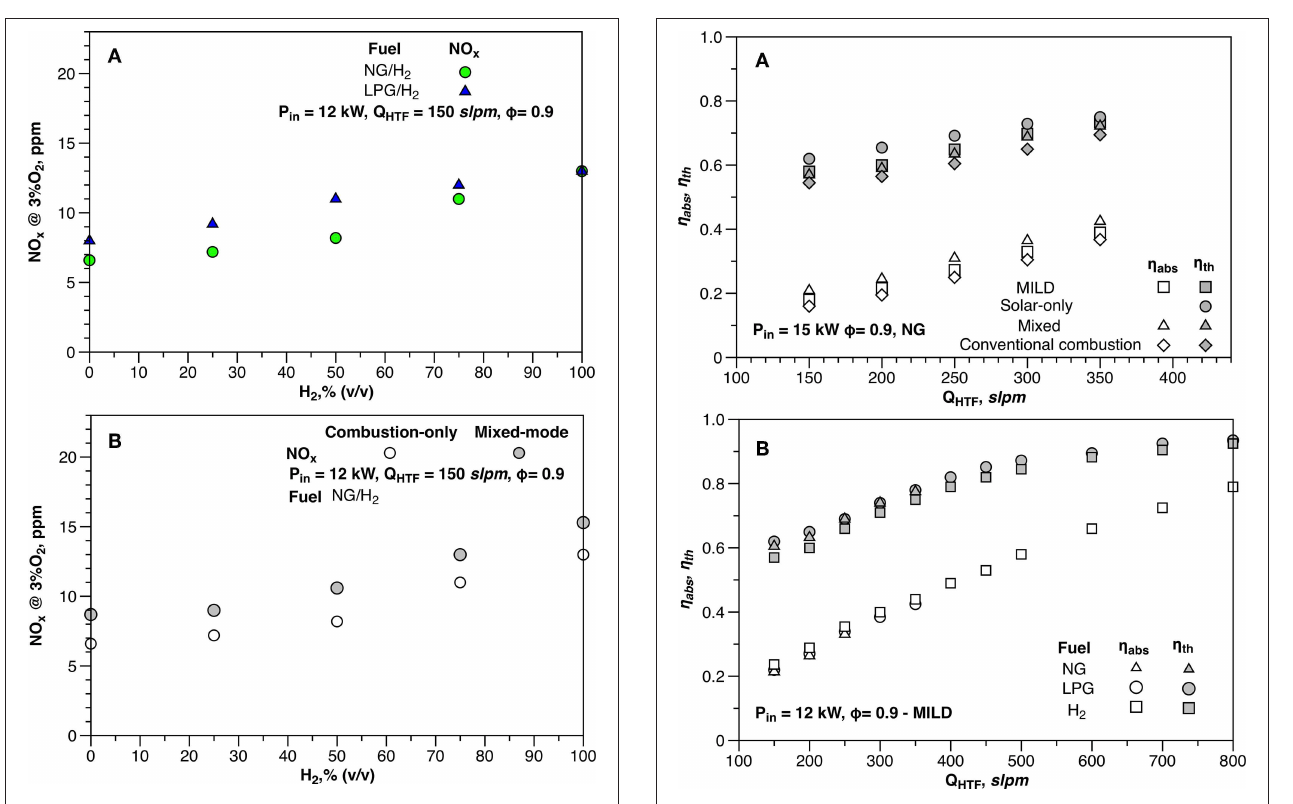
FIGURE 8 | Measured values of absorption ( η abs ) and thermal ( η th ) efficiencies for (A) the different modes of operation, and (B) the different fuel analyzed under MILD conditions. Data from Chinnici et al.